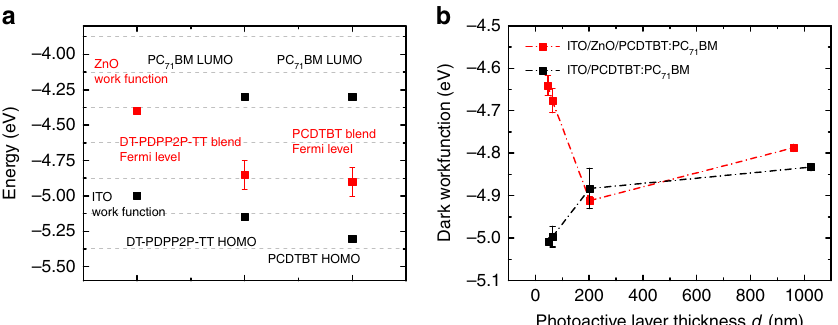
fi lms, a large change in the work function below 200 nm, but almost 71 BM